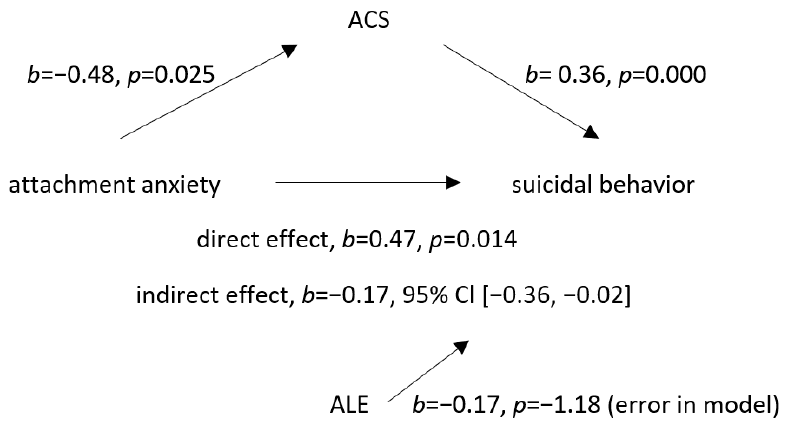
Figure 3. Mediation model with acquired capability for suicide (ACS) as the mediator of the association between attachment anxiety in relation to father and suicidal behavior. Adverse life experiences were included as a covariant. Higher attachment anxiety in relation to father decreased ACS and, consequently, decreased suicidal behavior, while attachment anxiety in relation to father directly increased suicidal behavior. Legend : ACS—acquired capability for suicide, ALE—adverse life experience, direct effect—association between attachment anxiety and suicidal behavior, and indirect effect—association between attachment anxiety and suicidal behavior when ACS was added as the mediating variable.